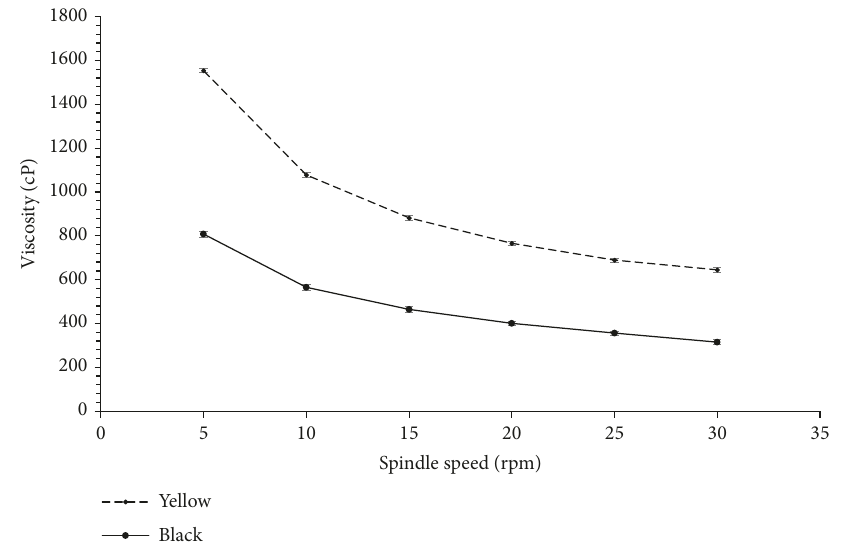
Figure 3: Viscosity profile of gels from yellow and black tigernut